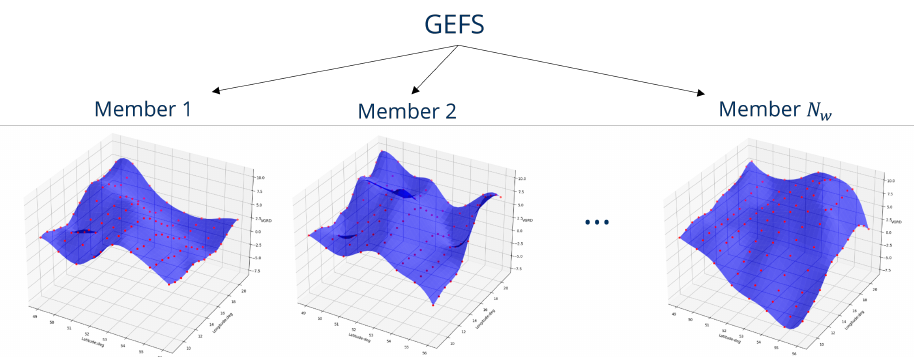
Figure 1. GEFS consists of N w different ensemble members ( N w = 21 for this study). A different b-spline approximation surface (blue surface) is obtained for a different GEFS member, based on the corresponding GRIB2 data (red